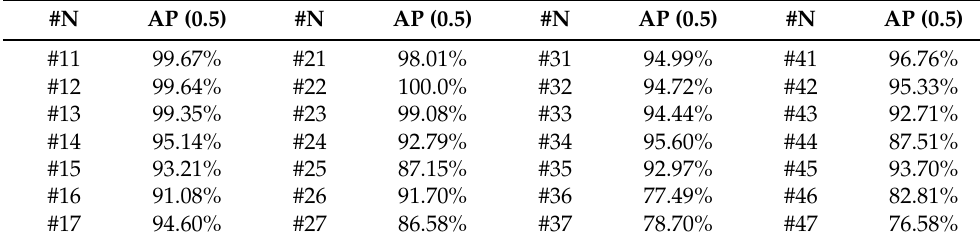
Table 2. Performance of tooth instance segmentation model by tooth